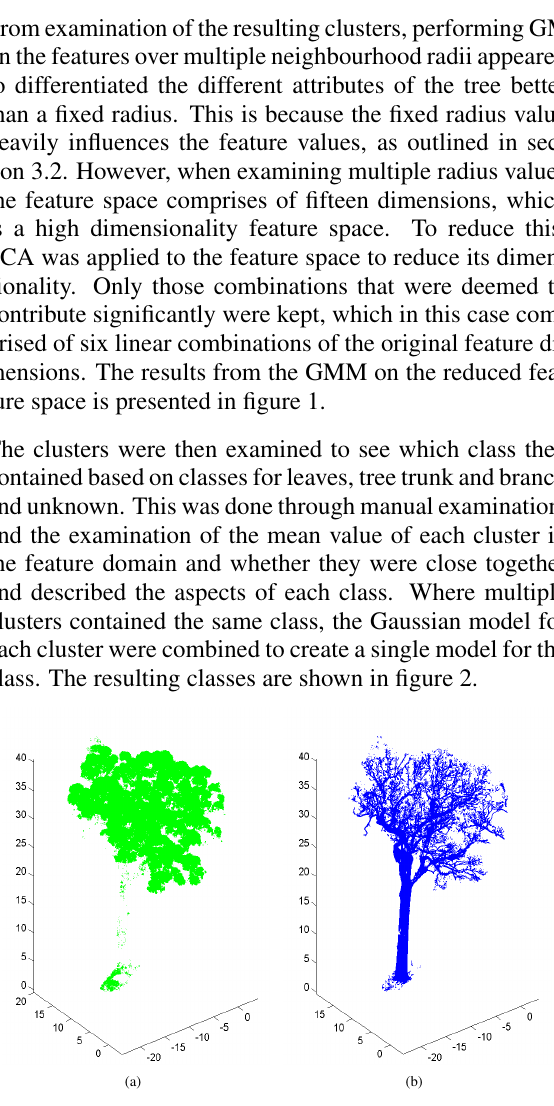
Figure 2: merged classes representing (a) leaves and (b) the trunk and branches from the Gaussian mixture model 4 TREE STRUCTURE